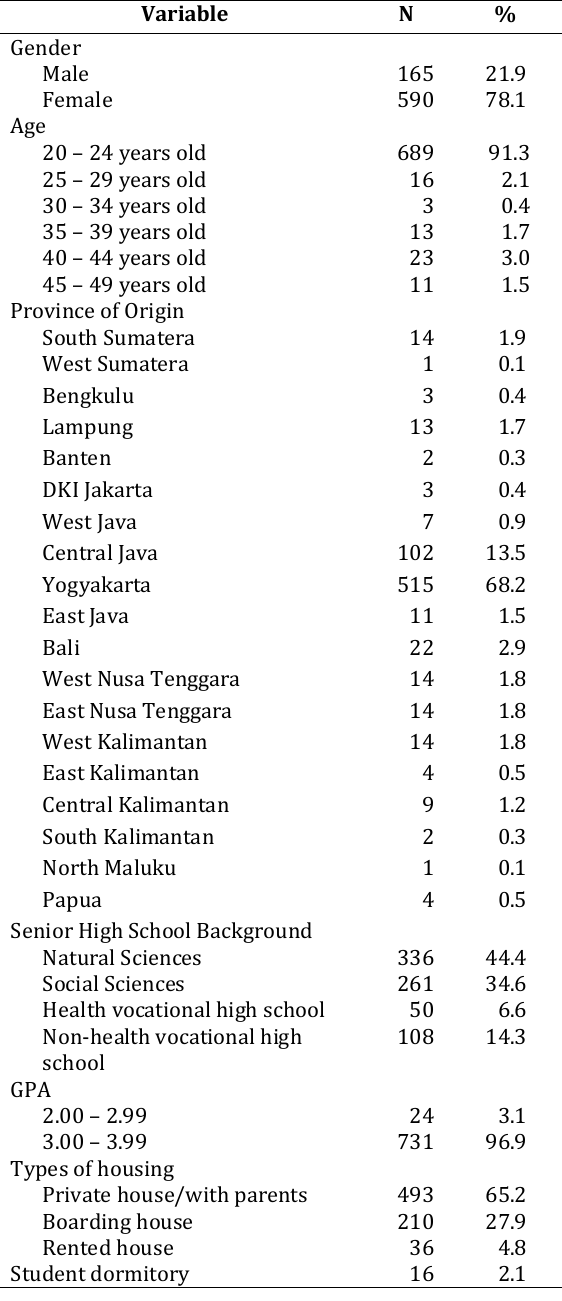
Table 1. The Demographic Profile of the